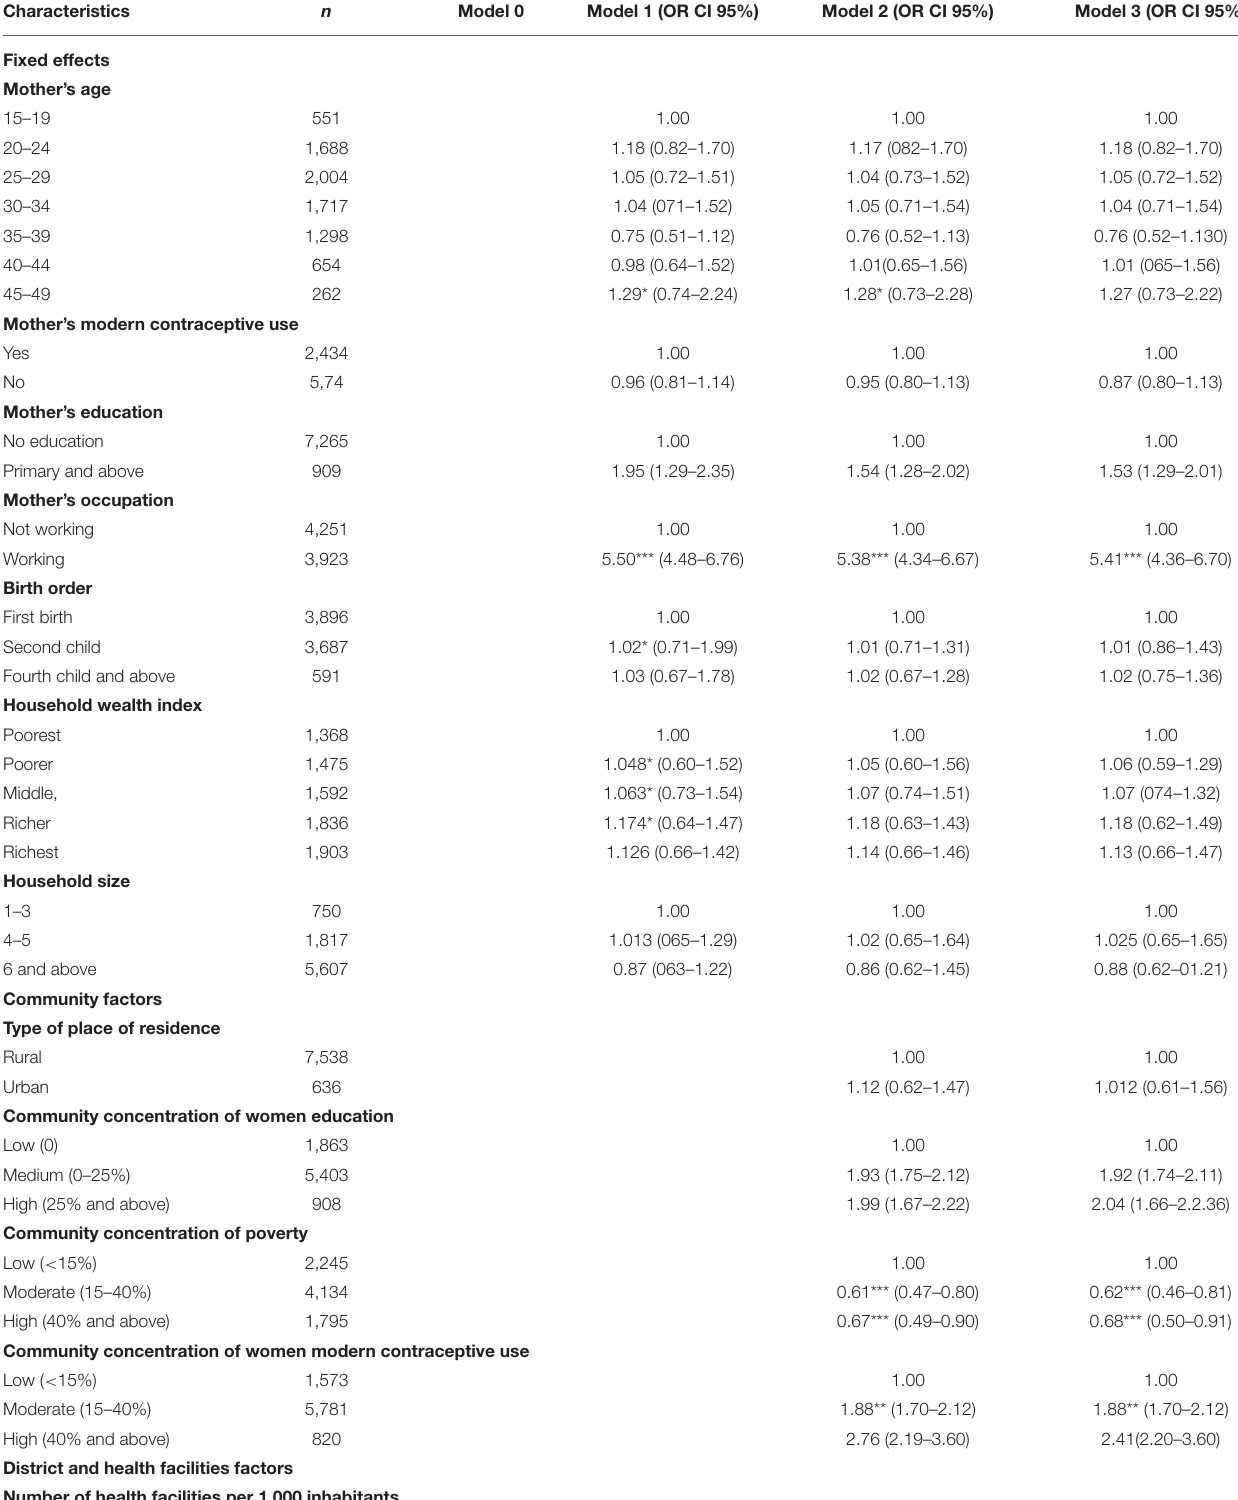
TABLE 4 | Parameter coefficients for the multilevel model of the use of ANC visits—assesses the role of variables at different levels.